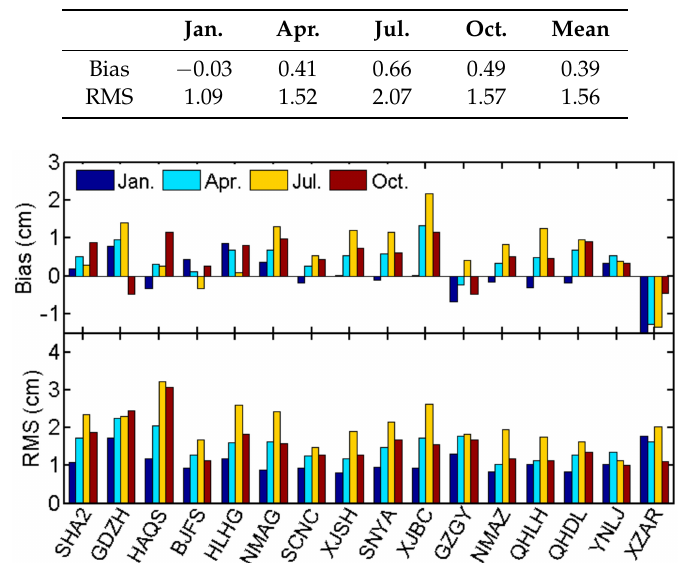
Table 5. Mean bias and error RMS of ZTD estimation using RtZTD at 16 test stations in different months (unit: cm).